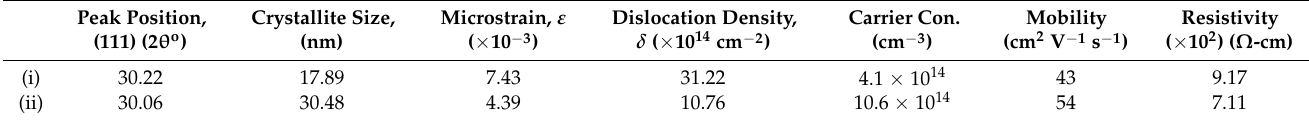
Table 2. Estimated structural and electrical properties of the PbS thin films with respect to the solution concentration.